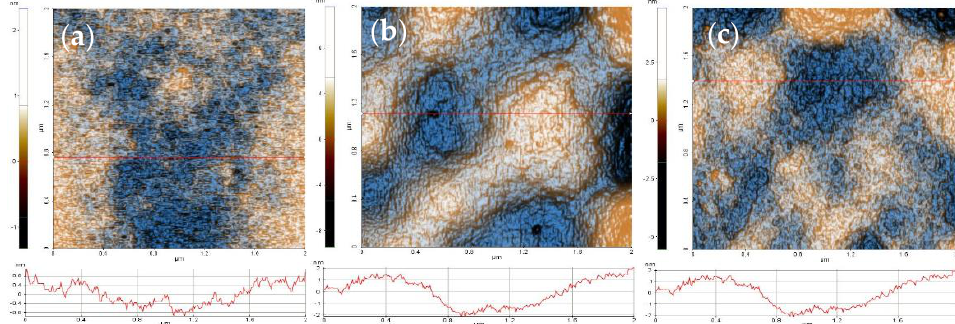
Figure 8. The AFM images and water drop contact angle profiles for: ( a ) (PAC 18 Na / PDADMAC) 20 , ( b ) (PAC 18 Na-C 14 TAB / PDAMAC) 20 , and ( c ) (PAC 18 Na-C 18 TAB / PDAMAC) 20 multilayer films exposed to C. albicans ATCC 10231 fungus. Characteristic surface profiles (line scans) are shown beneath each image.